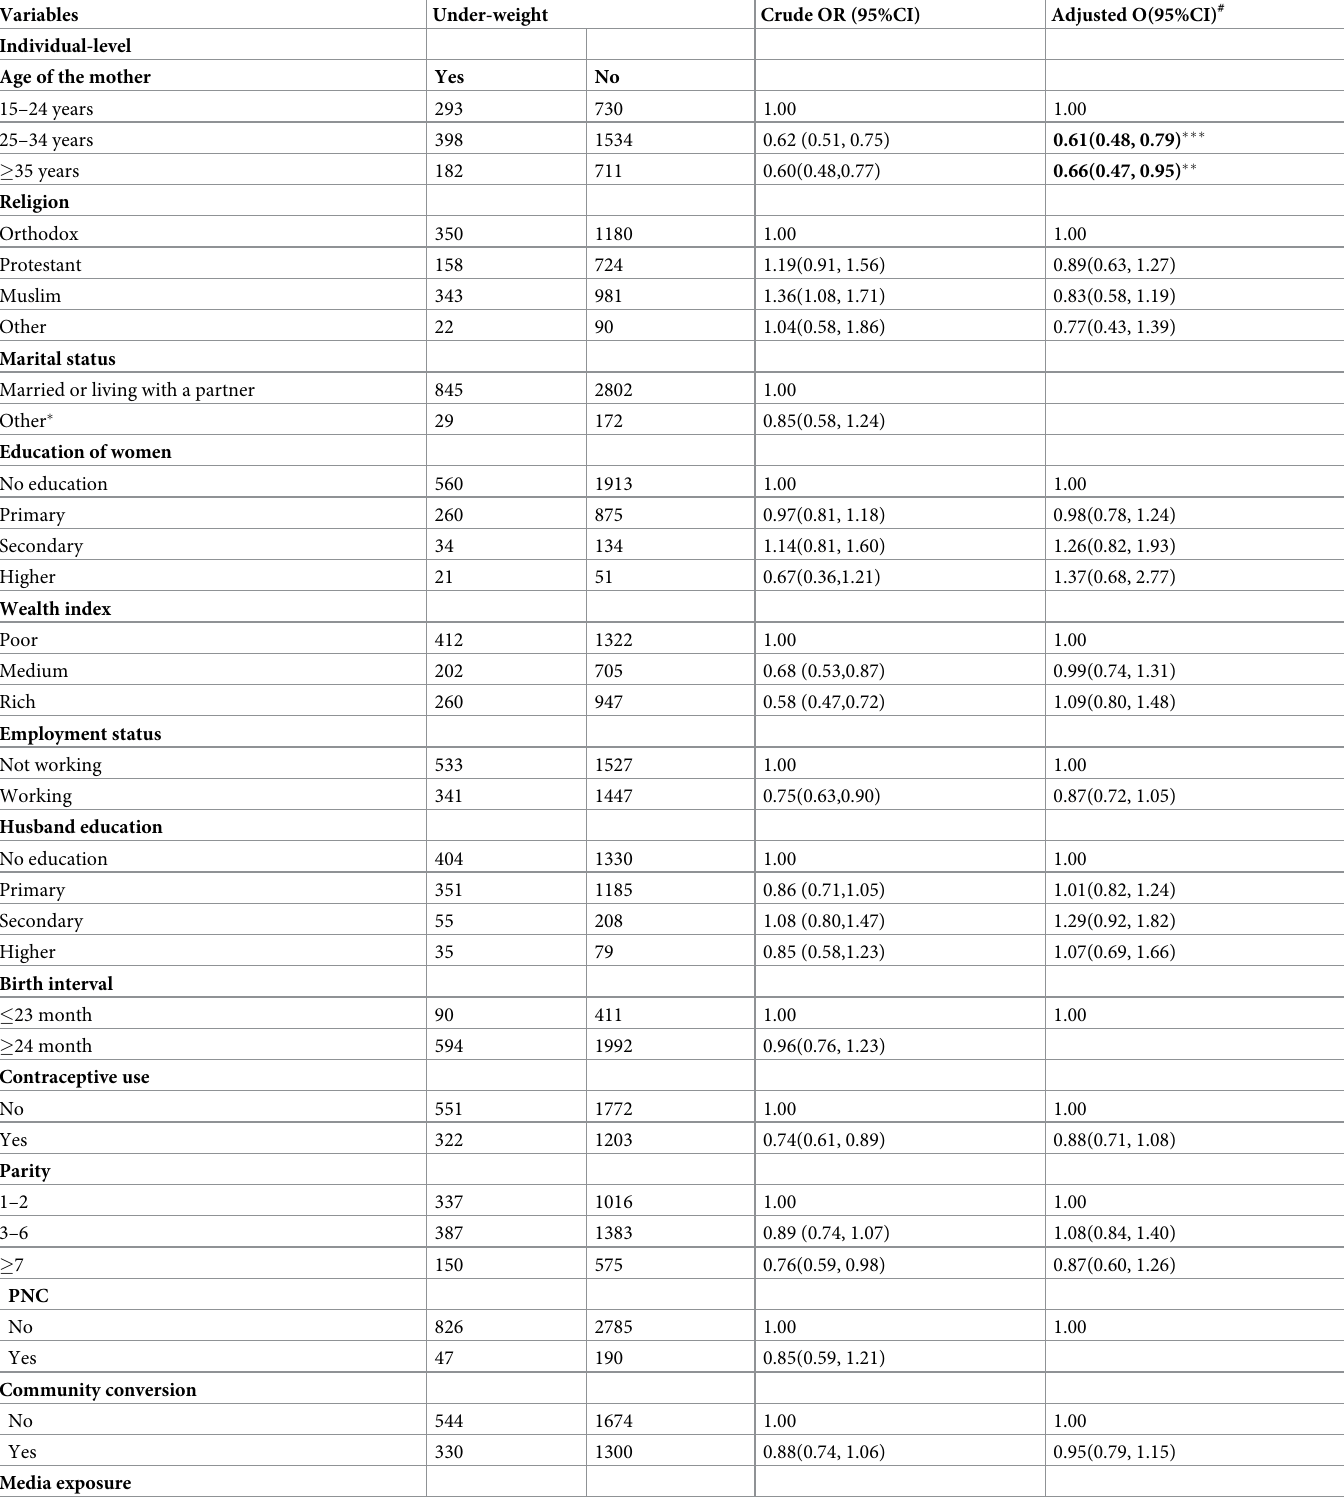
Table 3. Determinants of Underweight among lactating mother in Ethiopia, 2016; results for multilevel logistic